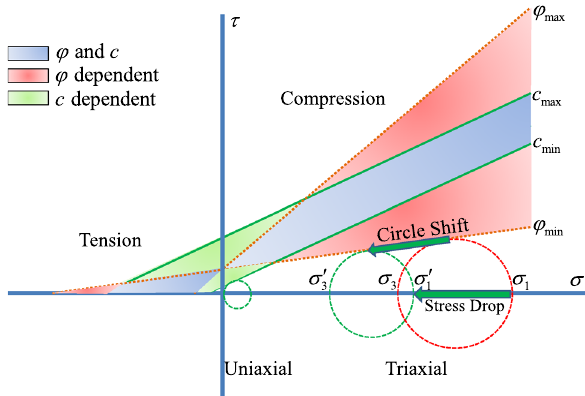
Fig. 7 Qualitative description of stress drop by cohesion and internal friction angle